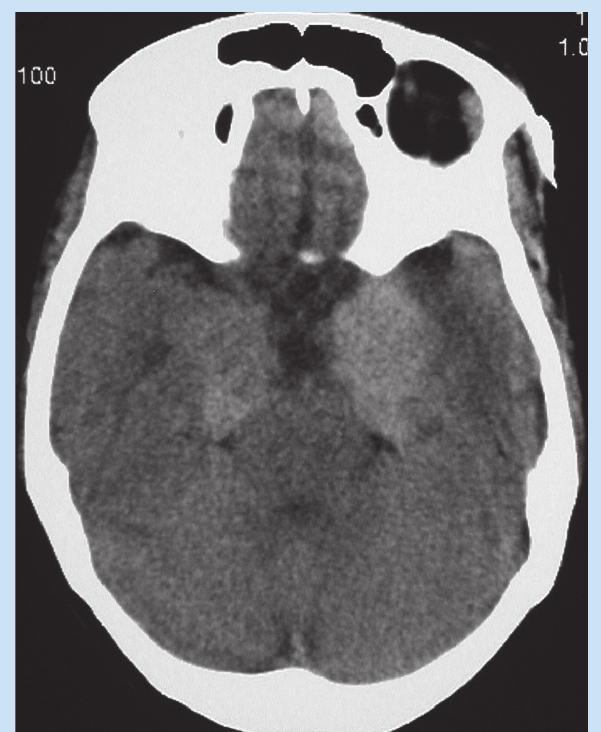
Fig. 3b. Post-contrast image showing bilateral contrast-enhanced cavern- ous meningiomas extending into the suprasellar